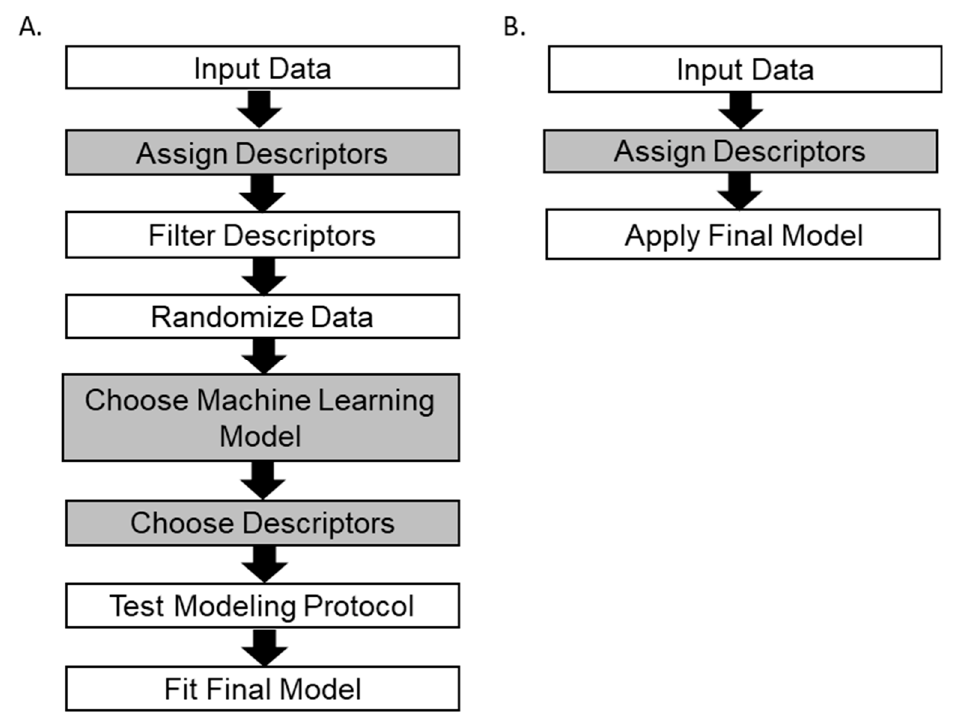
Figure 6. QSRR Automator workflow. Gray cells are steps where the user has the option to force a specific choice, such as by providing descriptors or adjusting settings. ( A ). Generating a model. Data are requested from the user, descriptors are assigned and filtered. Data are randomized. A machine learning model is chosen and tested with a cross-validation. All data are used for the final model. ( B ) Using a previously generated model as in Panel ( A ) retention time for new data can be predicted. Data are provided, descriptors provided if necessary and retention times are predicted by the model in use.